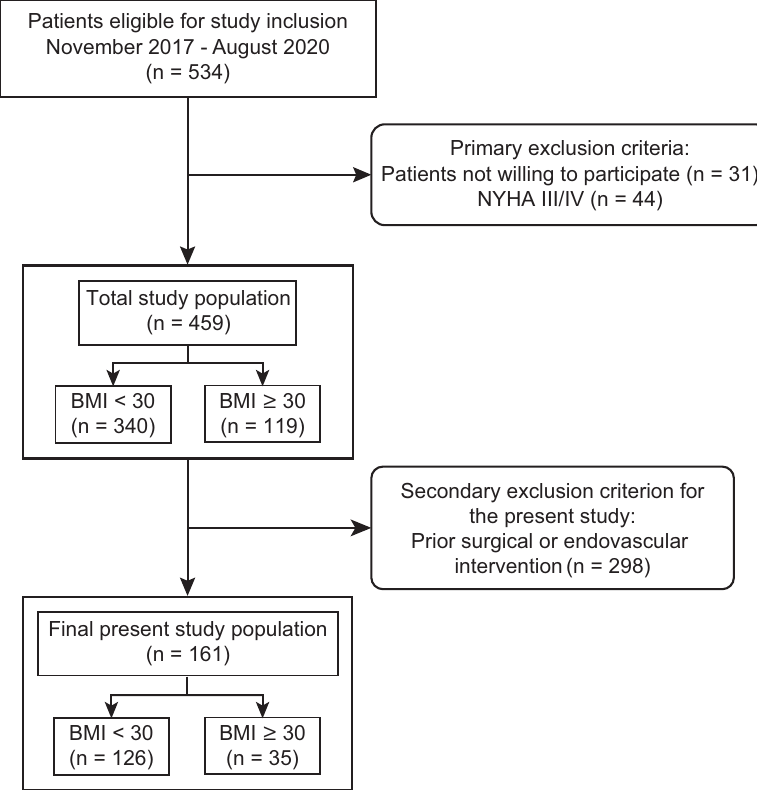
Figure 1. Flowchart of the